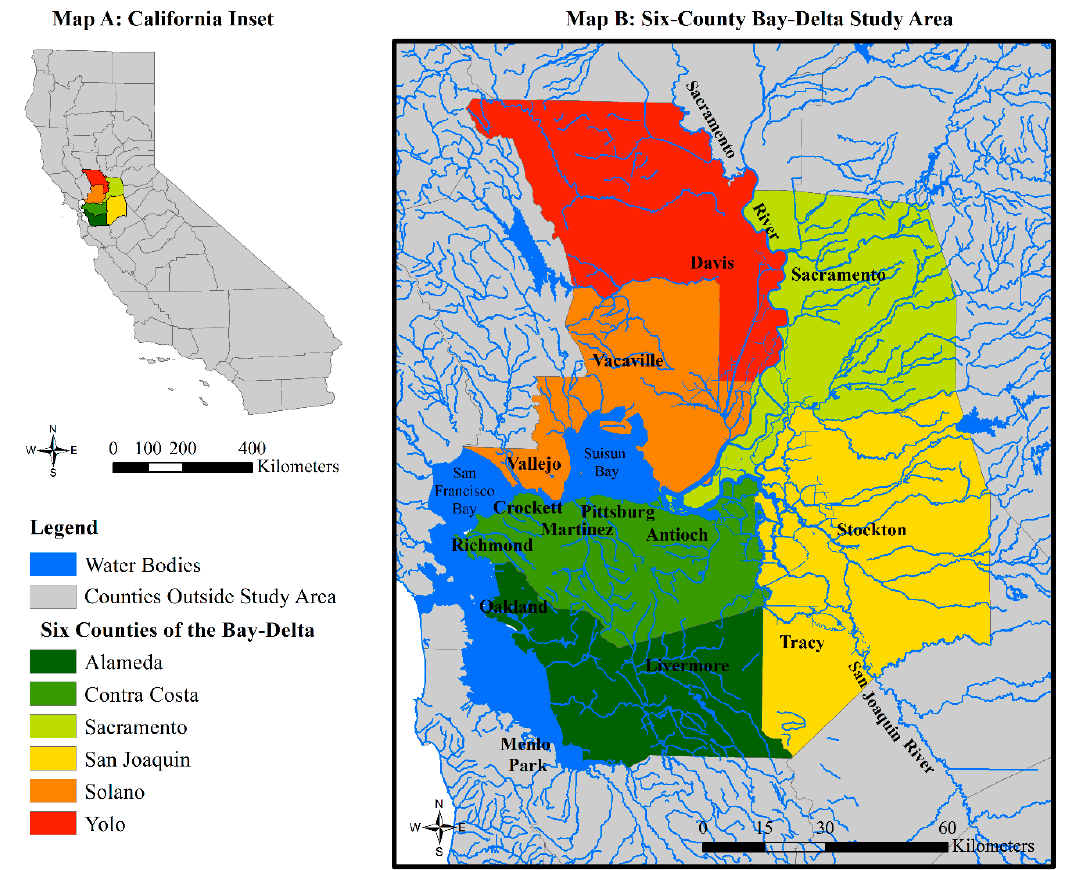
Figure 1. Map ( A ) California and Map ( B ) the six-county Bay-Delta study area.